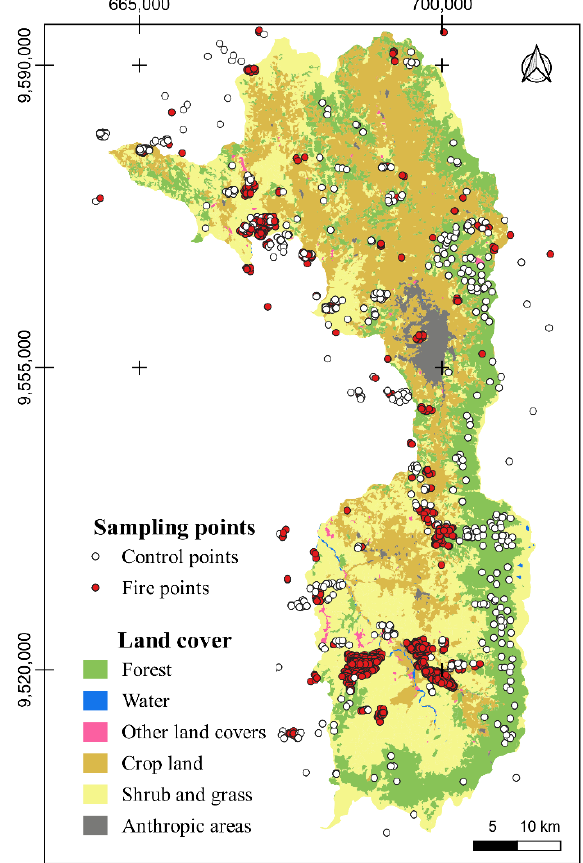
Figure 1. Sampling points and location area.